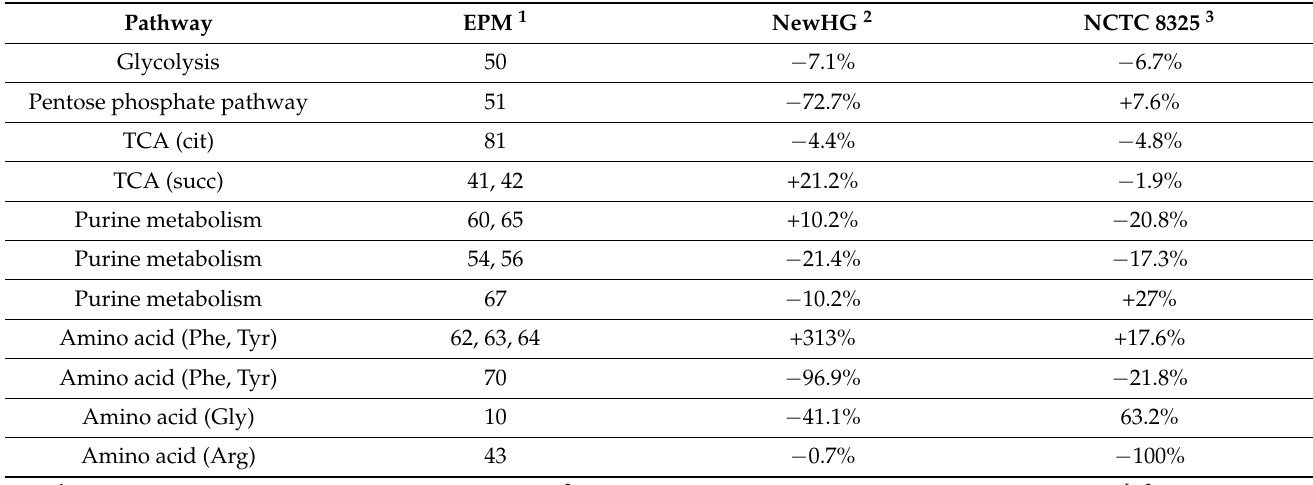
Table 2. Metabolic pathway effected by pknB mutation in S. aureus NCTC 8325 [10] and flux activity comparison with this study ( S. aureus